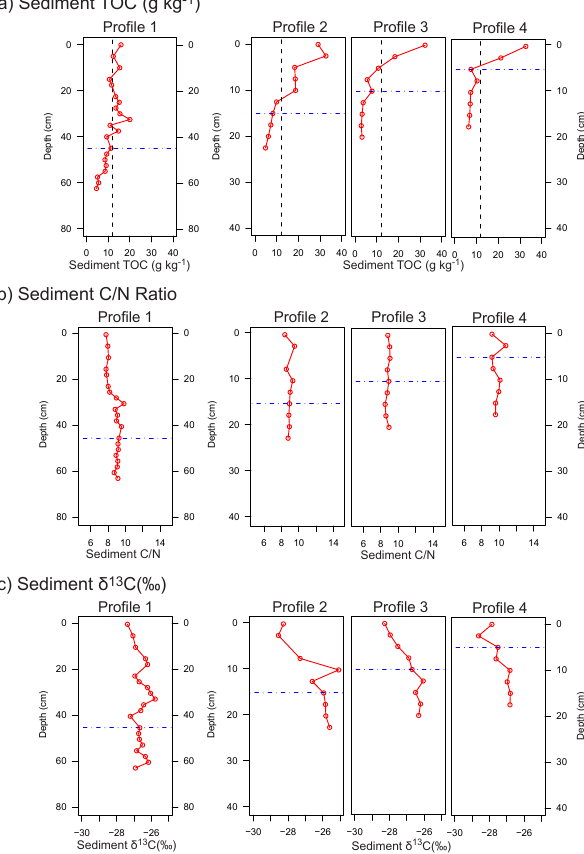
Fig. 10. Four sediment profiles of (a) sediment total organic carbon, (b) sediment carbon to nitrogen ratio (C:N), and (c) sediment δ 13 C, sampled at 2.5cm intervals. The horizontal dashed line represents the depth of the antecedent (1993) soil layer. The vertical dashed line represents the average carbon concentration of inflowing sedi-